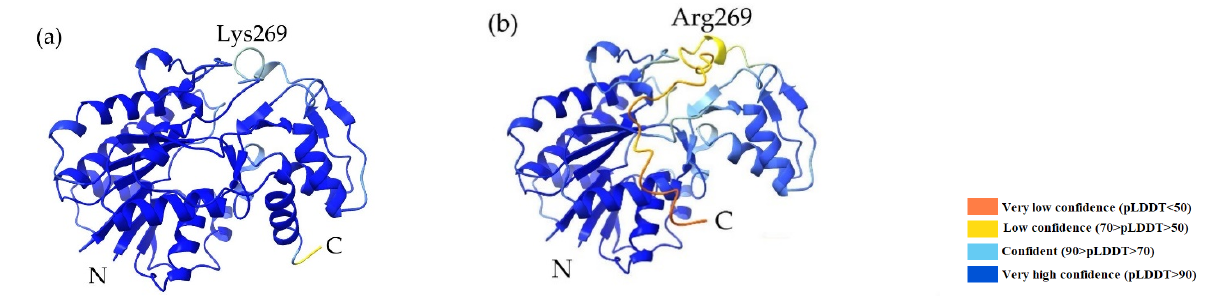
Figure 5. The 3D structures of the gene products of gmhD predicted by the AlphaFold (a) in Shigella sonnei 4303 and (b) in Shigella sonnei 4351. The colors show the confidence values of the prediction. The frameshift mutation causes the amino acid change at the 269 th position. N and C mark the respective termini of the polypeptide chains.